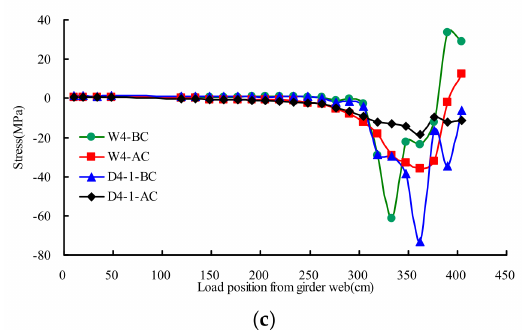
Figure 12. Hotpot stresses of rib web-to-deck under transverse wheel positions: ( a ) D2; ( b ) W3 and D3; ( c ) W4 and D4.